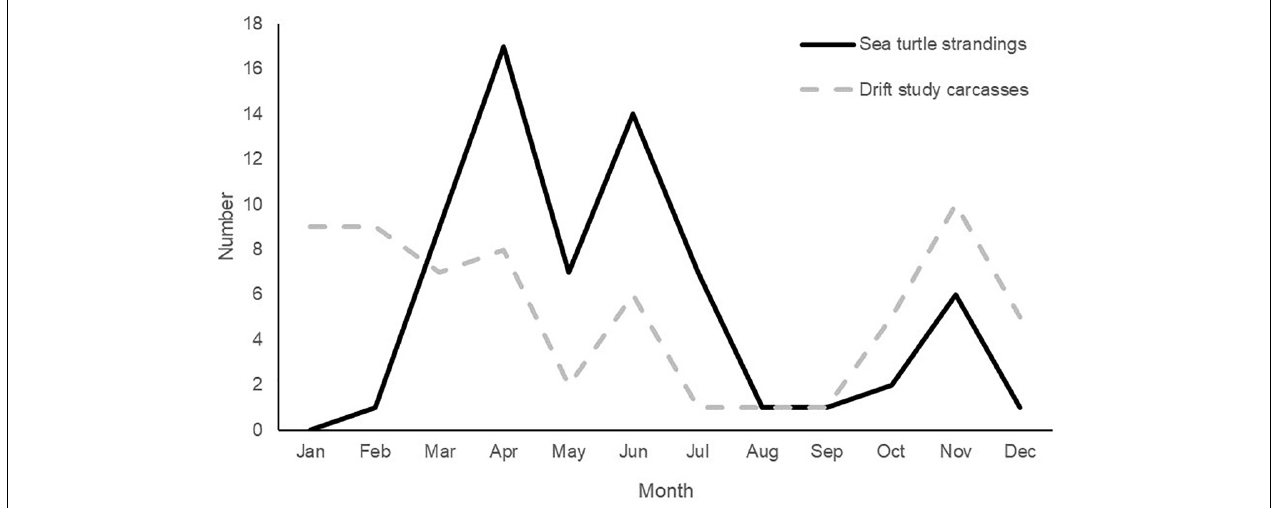
FIGURE 10 | Number of documented sea turtle strandings ( n = 66) and drift study carcasses ( n = 51) that beached in Mississippi in 2017. Stranding data from the Mississippi Sea Turtle Stranding and Salvage Network database (https://grunt.sefsc.noaa.gov/stssnrep/).